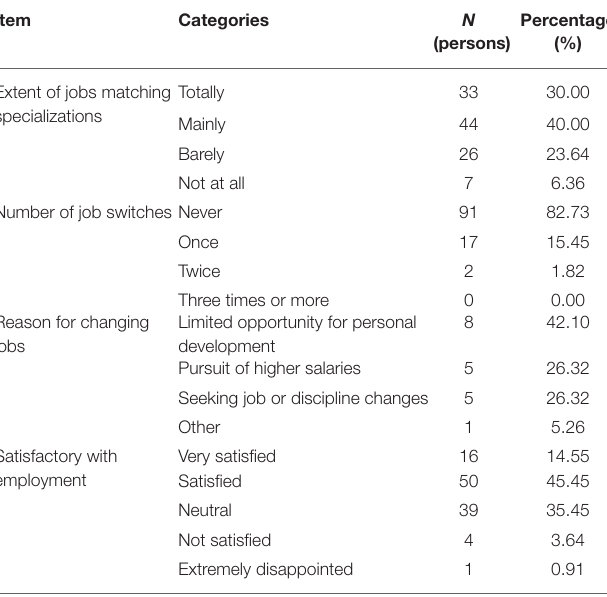
TABLE 4 | Employment stability of PHPM Master’s graduates.